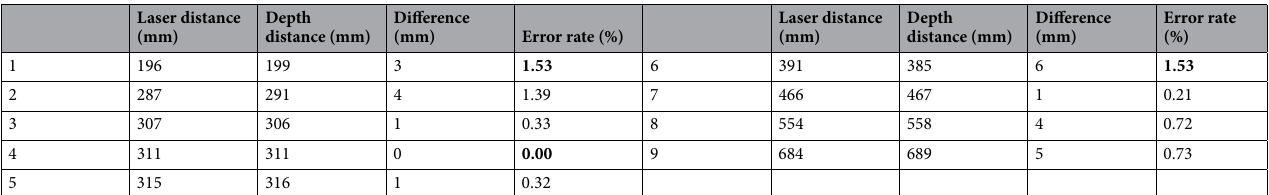
Table 3. Z-axis distance experiment: outdoors. Significant values are in bold.